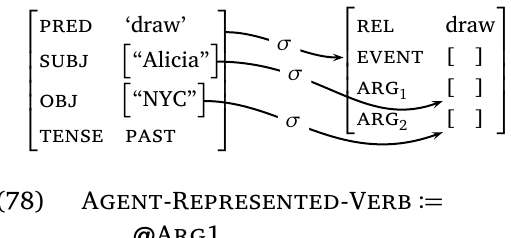
Figure 6: Structures and correspondences